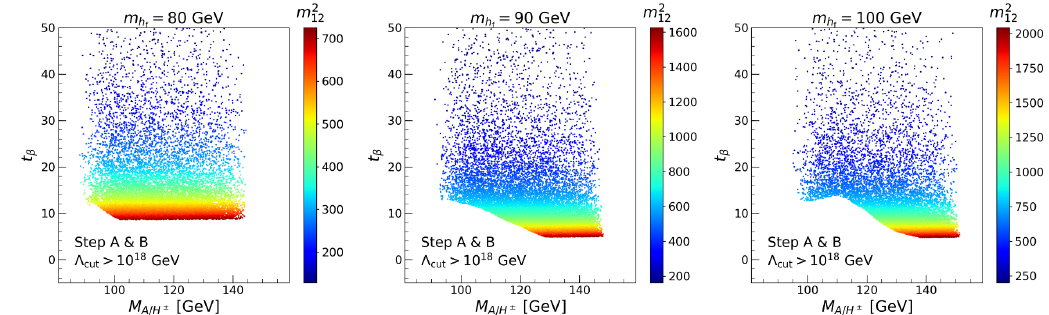
Figure 2 . t β versus M for the parameter points with Λ cut > 10 18 GeV . The color codes A/H ± denote m 2 in units of GeV 2 . The results for m h = 80 , 90 , 100 GeV are in the left, middle, and 12 f right panel,